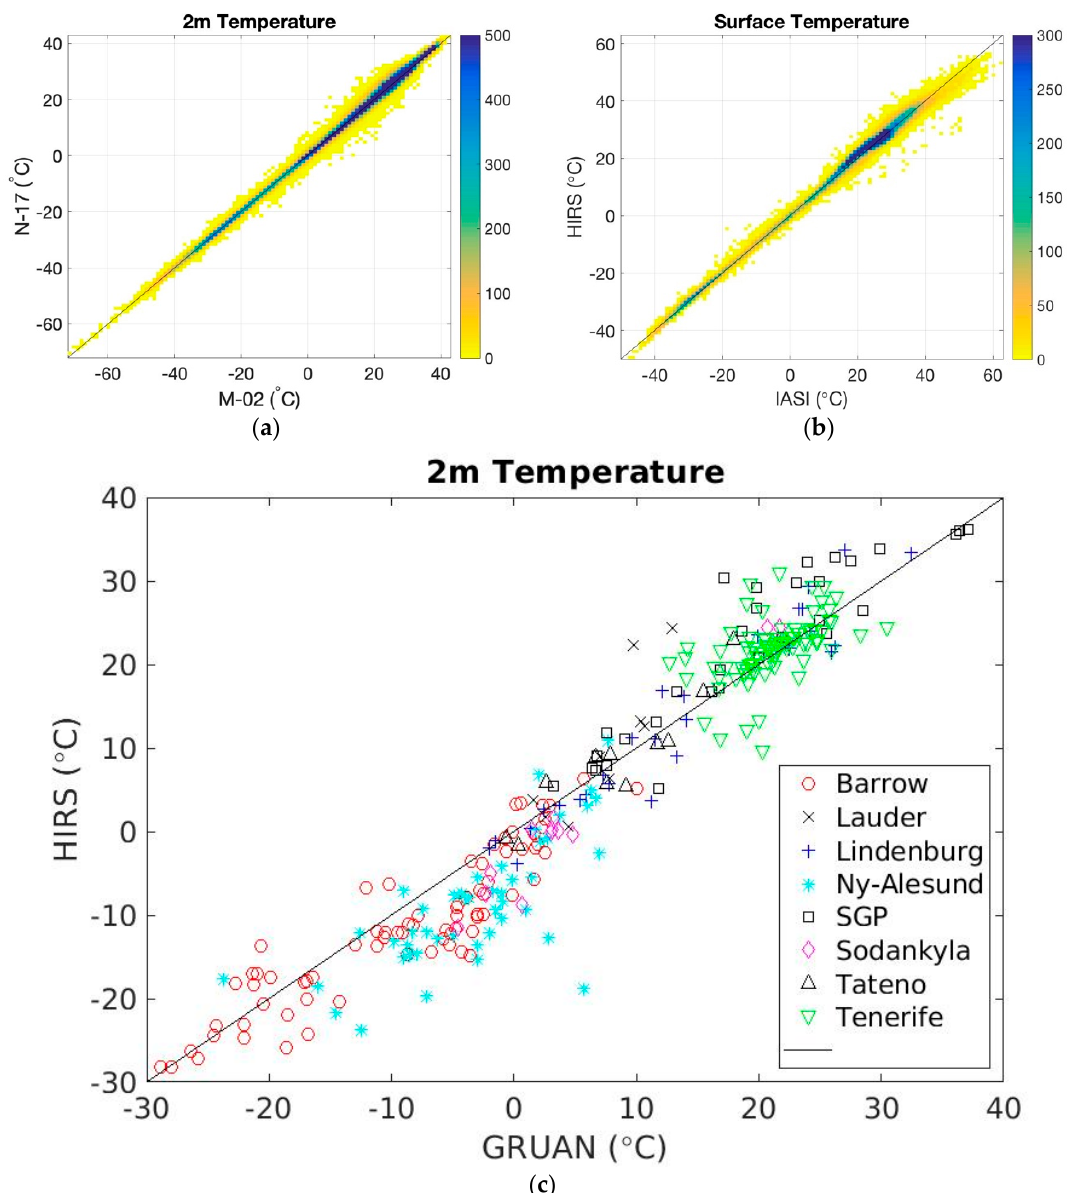
Figure 7. ( a ) Histogram of 2 m temperature for M-02 vs. N-17. Matches represent locations all over the globe during the time period of 2007–2009; ( b ) histogram of surface temperature for IASI vs. HIRS in January 2014; ( c ) histogram of 2 m temperature for GRUAN vs. HIRS during 2006–2017.